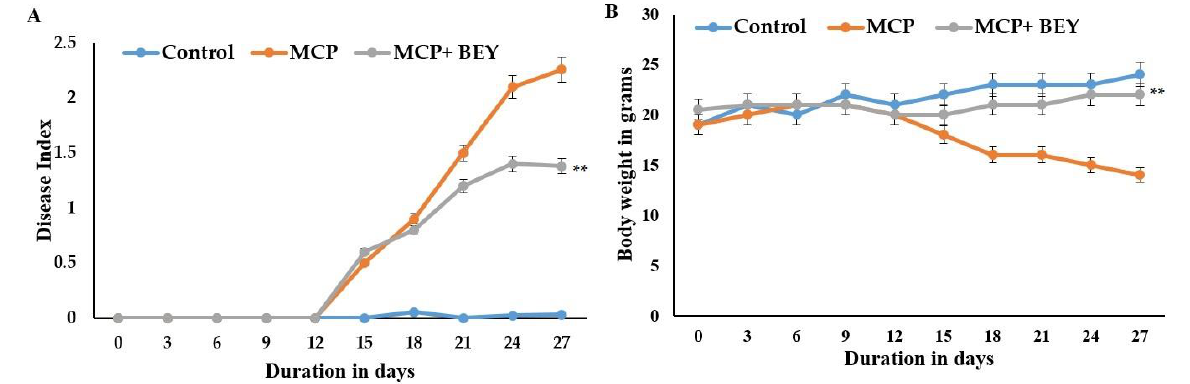
Figure 3. Effect of BEY on in vivo EAE in C57Bl/6J mouse model. Mice were immunized with MOG and pertussis toxin on 1st and 3rd days, respectively. Beginning on the third day of immunization, mice were given BEY (10 × 7.5 cfu load/20 g of mouse body weight). ( A ) Disease index of EAE pathology over 27 days of MOG immunization. The clinical signs were graded as described in the Materials and methods section; ( B ) body weight (g) of EAE mice and BEY-treated mice. Values are expressed using Student’s t -test and one-way ANOVA (significant at ** p ≤